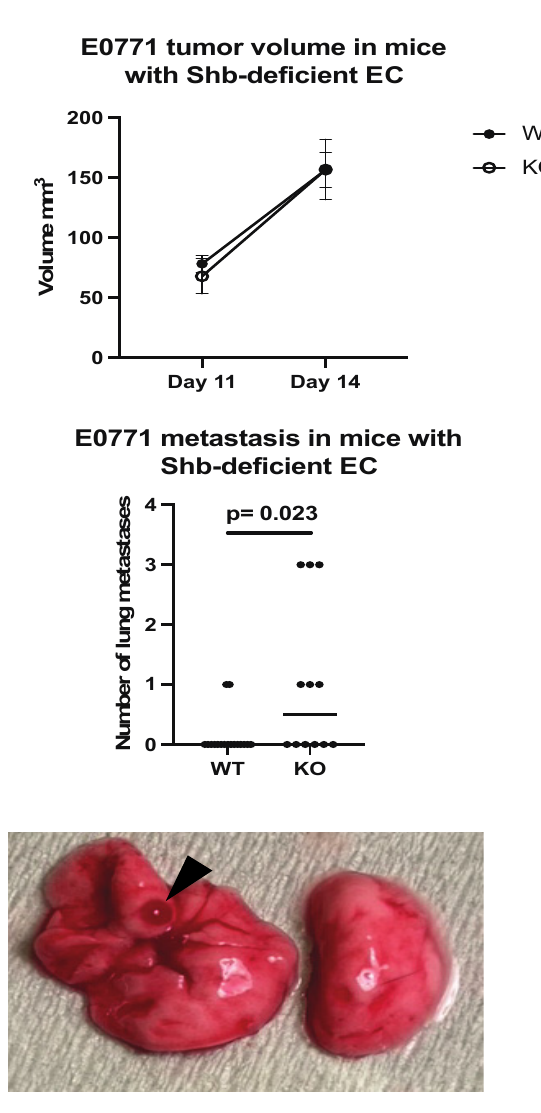
Figure 1. Tumor growth and metastasis in wild type (WT) and EC Shb knockout (KO) mice. WT n = 12 and KO n = 8 for tumor growth and 17 and 12 for metastasis, respectively. A Chi-square test was employed to compare WT and KO. A hemorrhagic metastasis is indicated by an arrow head.